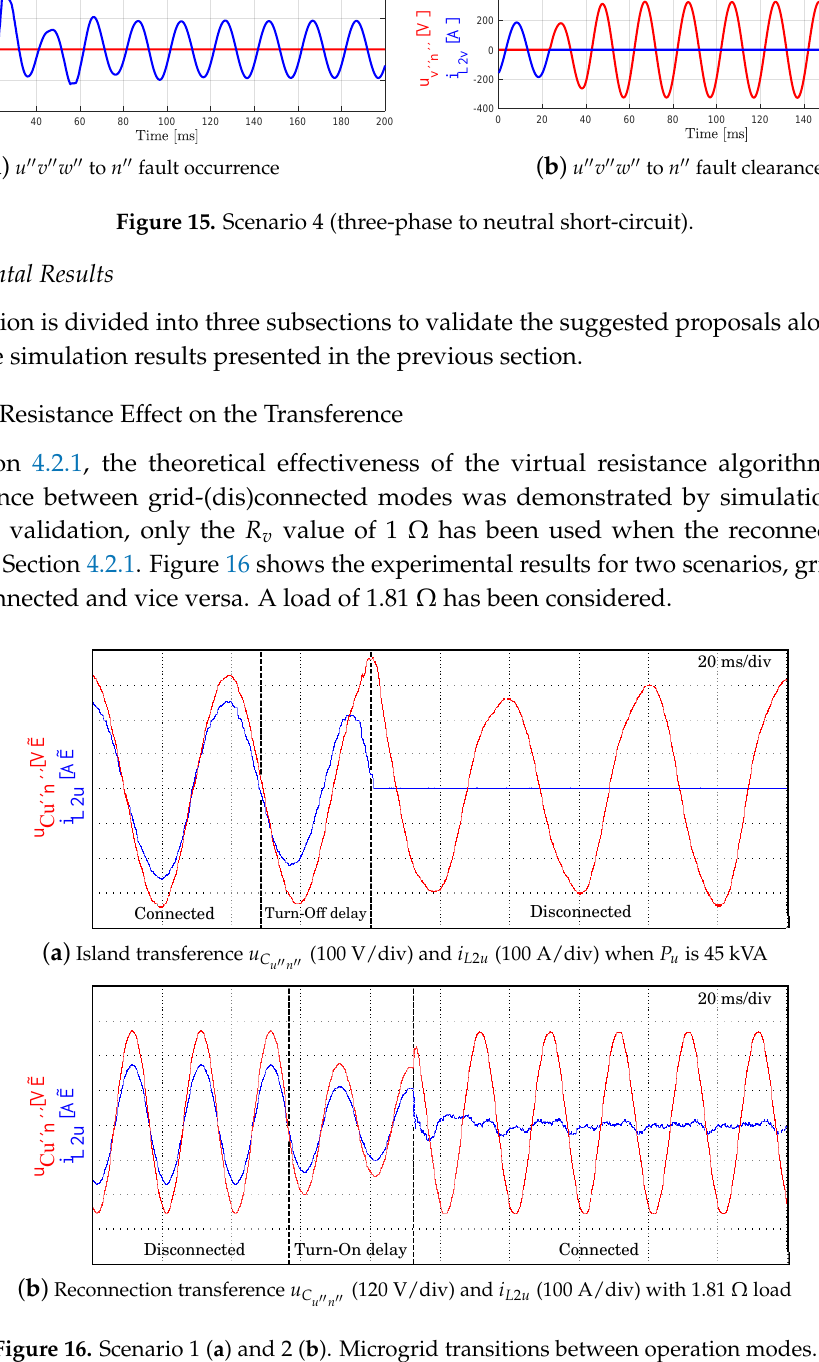
Figure 16. Scenario 1 ( a ) and 2 ( b ). Microgrid transitions between operation